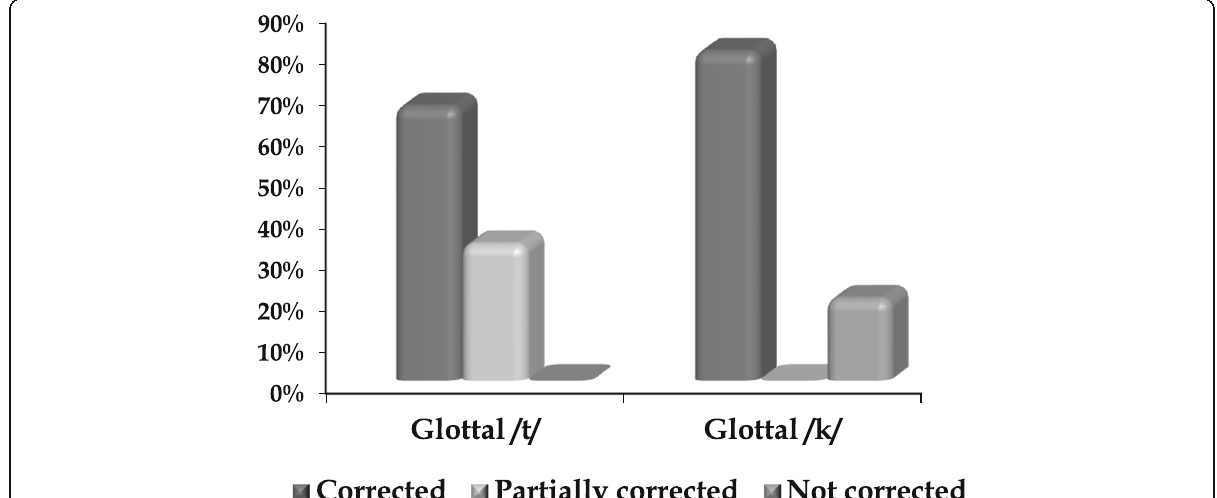
Fig. 4 Distribution of the studied cases after intervention ( n =